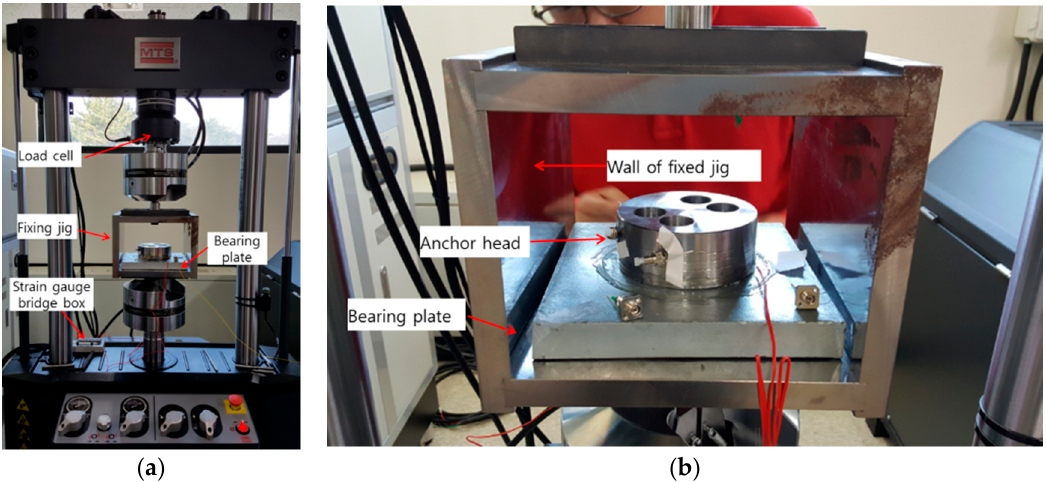
Figure 6. Anchor loading by universal testing machine (UTM) ( a ) UTM ( b ) the beating plate with a sensing fiber.